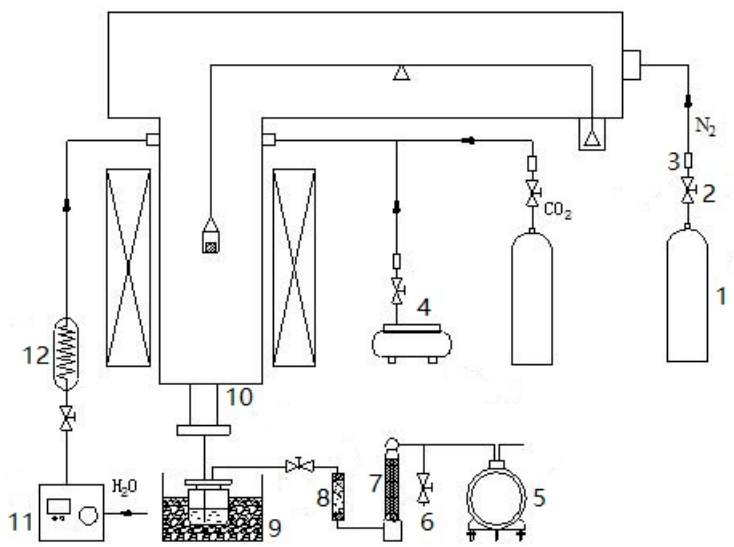
Figure 2. Multifunctional pyrolysis/gasification experimental system. 1, Cylinders; 2, needle valve; 3, pressure gauge; 4, air compressor; 5, wet-type gas flowmeter; 6, sampling port; 7, dryer; 8, secondary tar absorption device; 9, cold water bath; 10, thermobalance; 11, plunger pump; 12, steam generator.